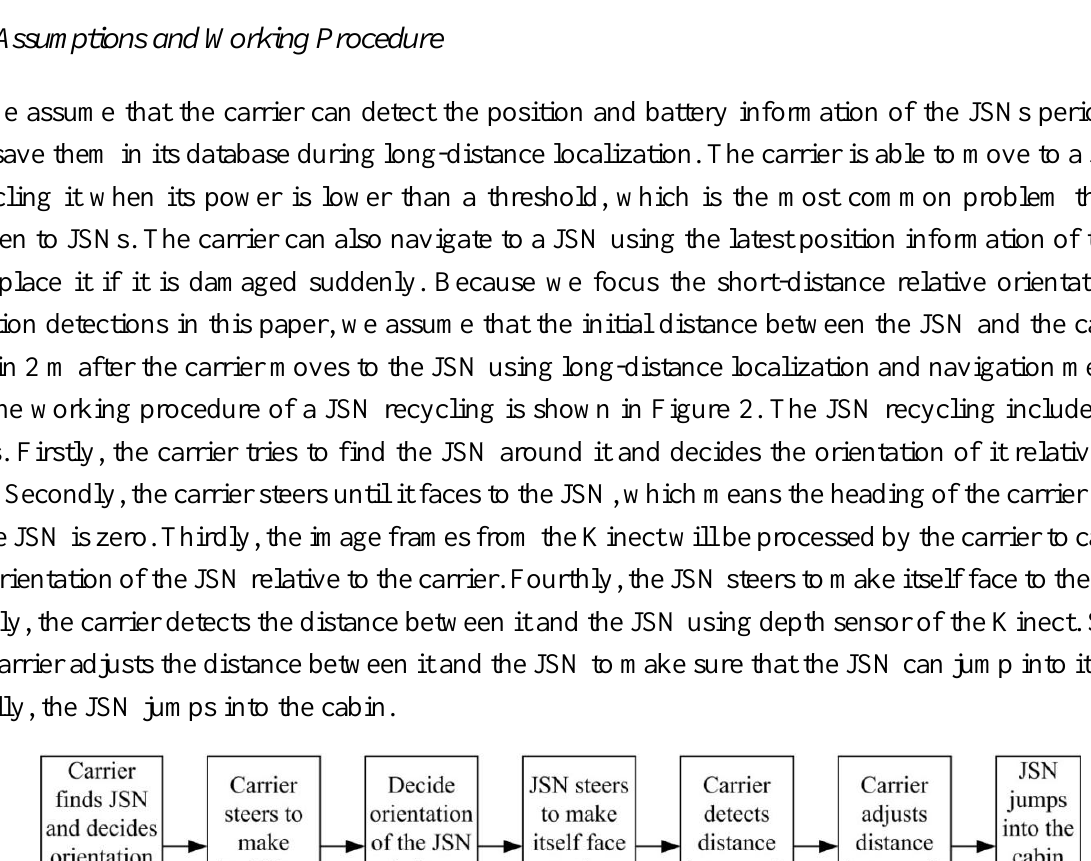
Figure 1. Components of the jumping sensor nodes recycling system.